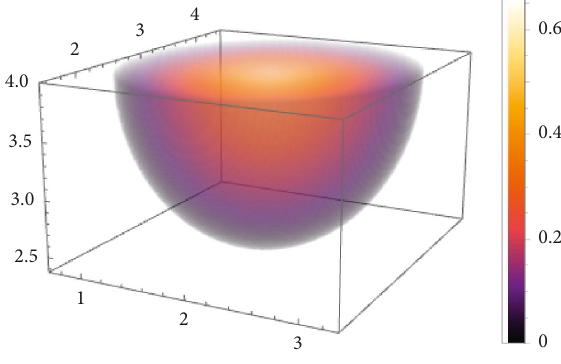
Figure 6: B 3 D half − cut .